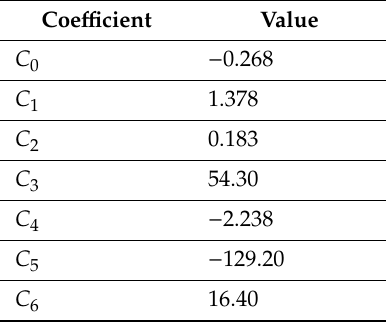
Table 3. Split-Window Algorithm (SWA) coe ffi cients for Jimenez-Munoz et al. [44]. Algorithm obtained from a numerical solution using MODTRAN.